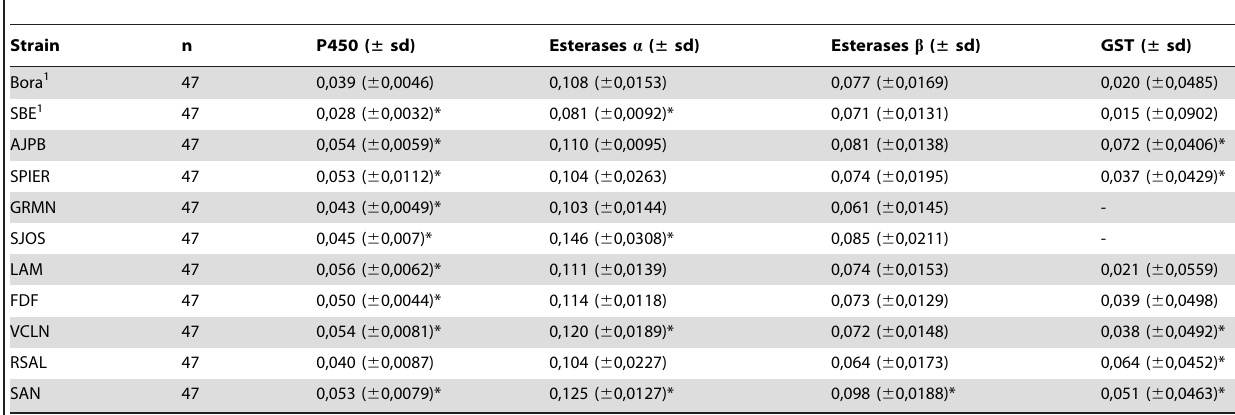
Table 2. Detoxification enzyme activities in adults of the populations of Martinique and the laboratory strains: cytochrome P450 monooxygenases (P450s; nmol P450 U/mg protein), Esterase ( a and b -CCEs; a / b -Naphtol/min/mg protein) and Glutathione-S- transferases (GSTs; GSH/min/mg protein).